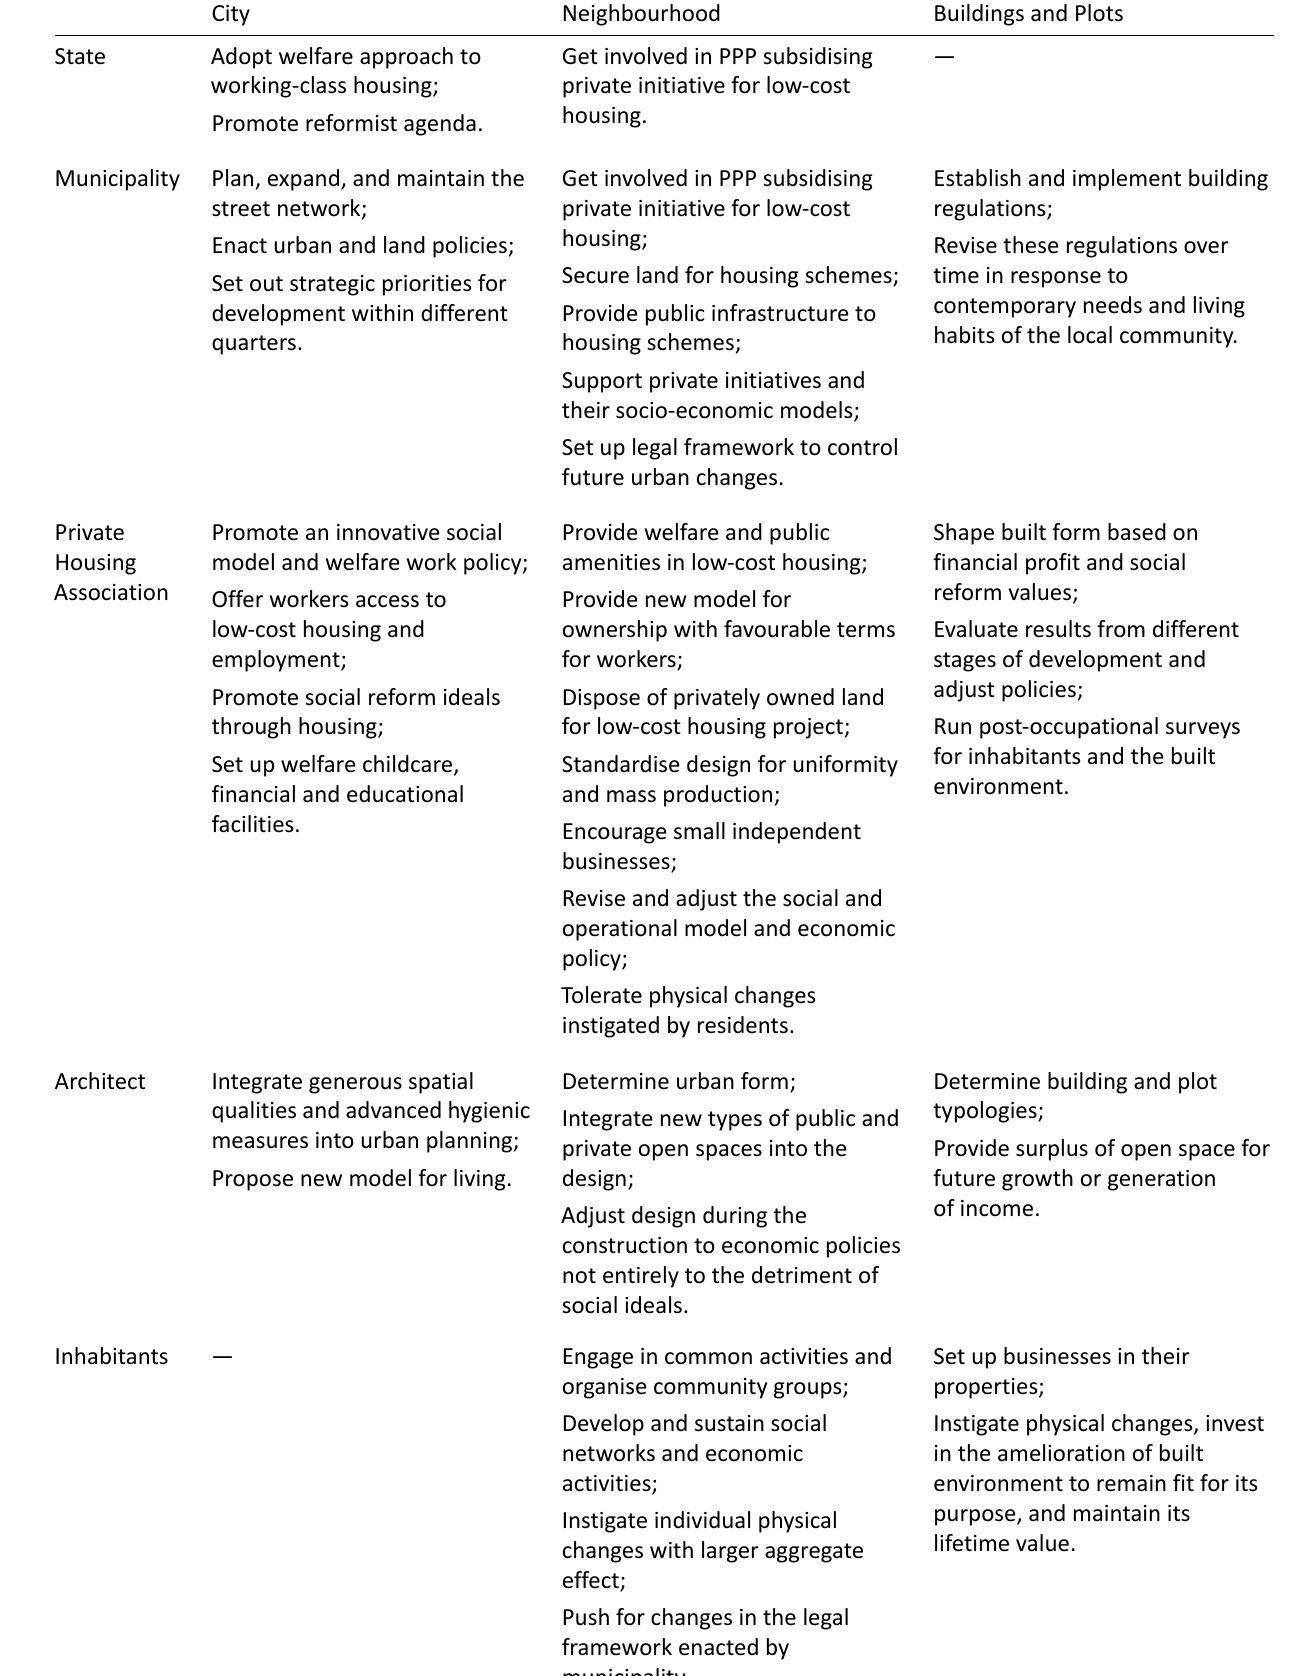
Table 1. Summary of means of change employed by different agents at different